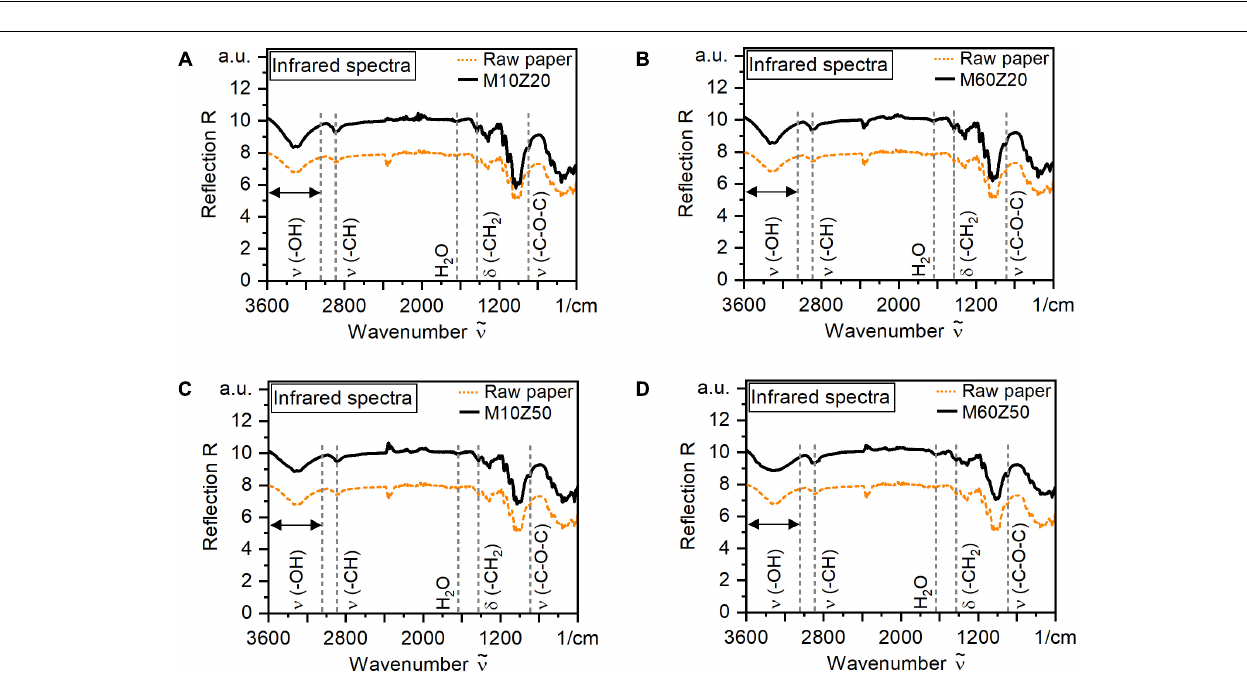
FIGURE 3 | Infrared spectra with peak definition of raw paper M (Basis: cotton linters, Hahnemühle FineArt GmbH) and Cottonid variants (A) M10Z20, (B) M60Z20, (C) M10Z50, and (D) M60Z50.